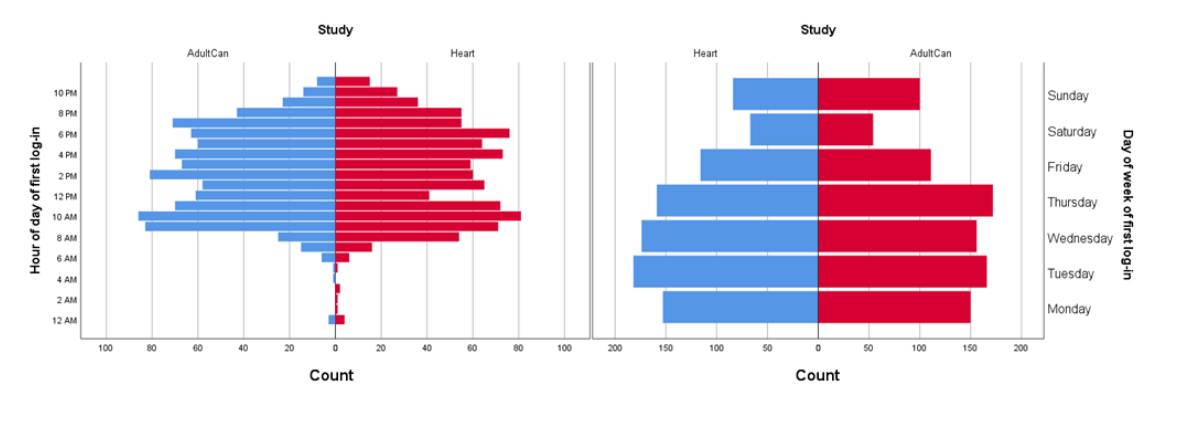
Figure 1. The time of day and day of week for participants’first log-in.